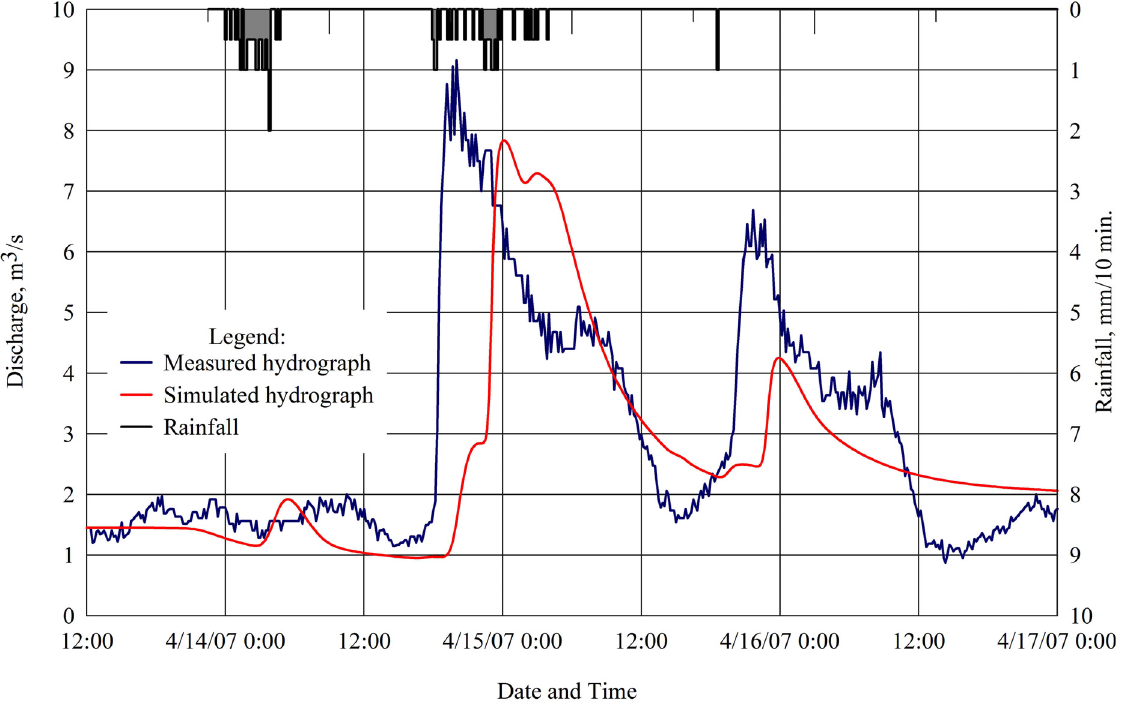
Figure 4. Results of hydrologic model validation. The graph shows a comparison between the actual (measured) hydrograph simulated by the model and the measured hydrograph for the 13–17 April 2007